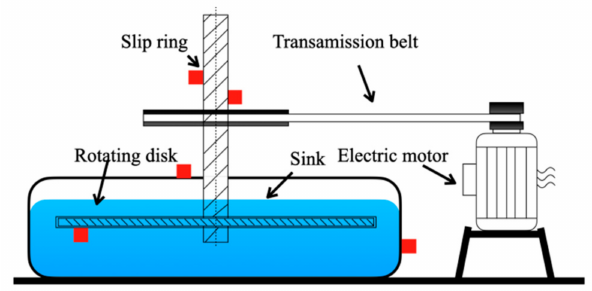
Figure 2. Schematic of hydro-turbine model test